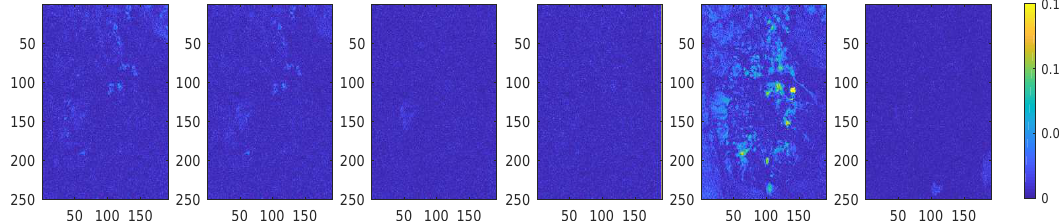
Figure 9. Maps of reconstruction error. From left to right: FCLS, SUnSAL, K-Hype ( G ), NDU ( G ), IIKNMF ( G ), Proposed ( G ).